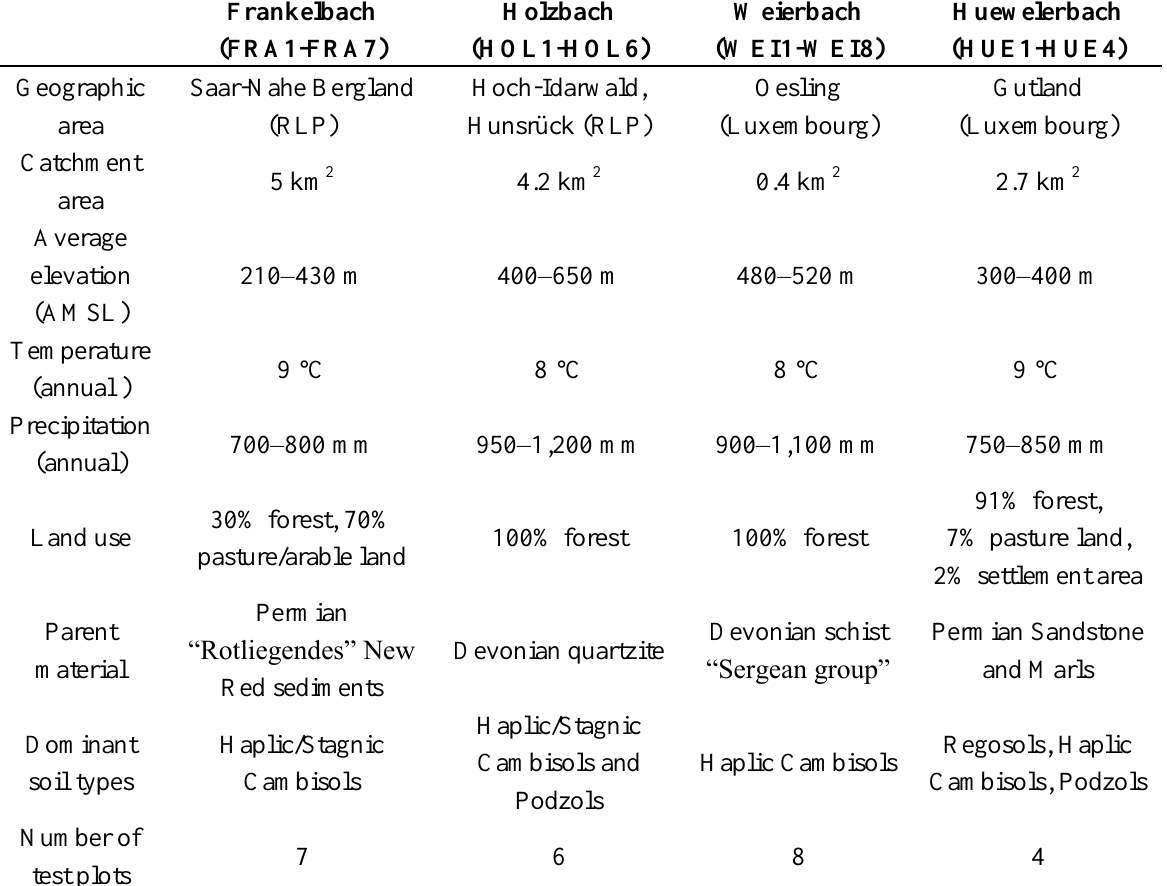
Table 1. Basic characteristics of the ForeStClim test sites in Rhineland-Palatinate and